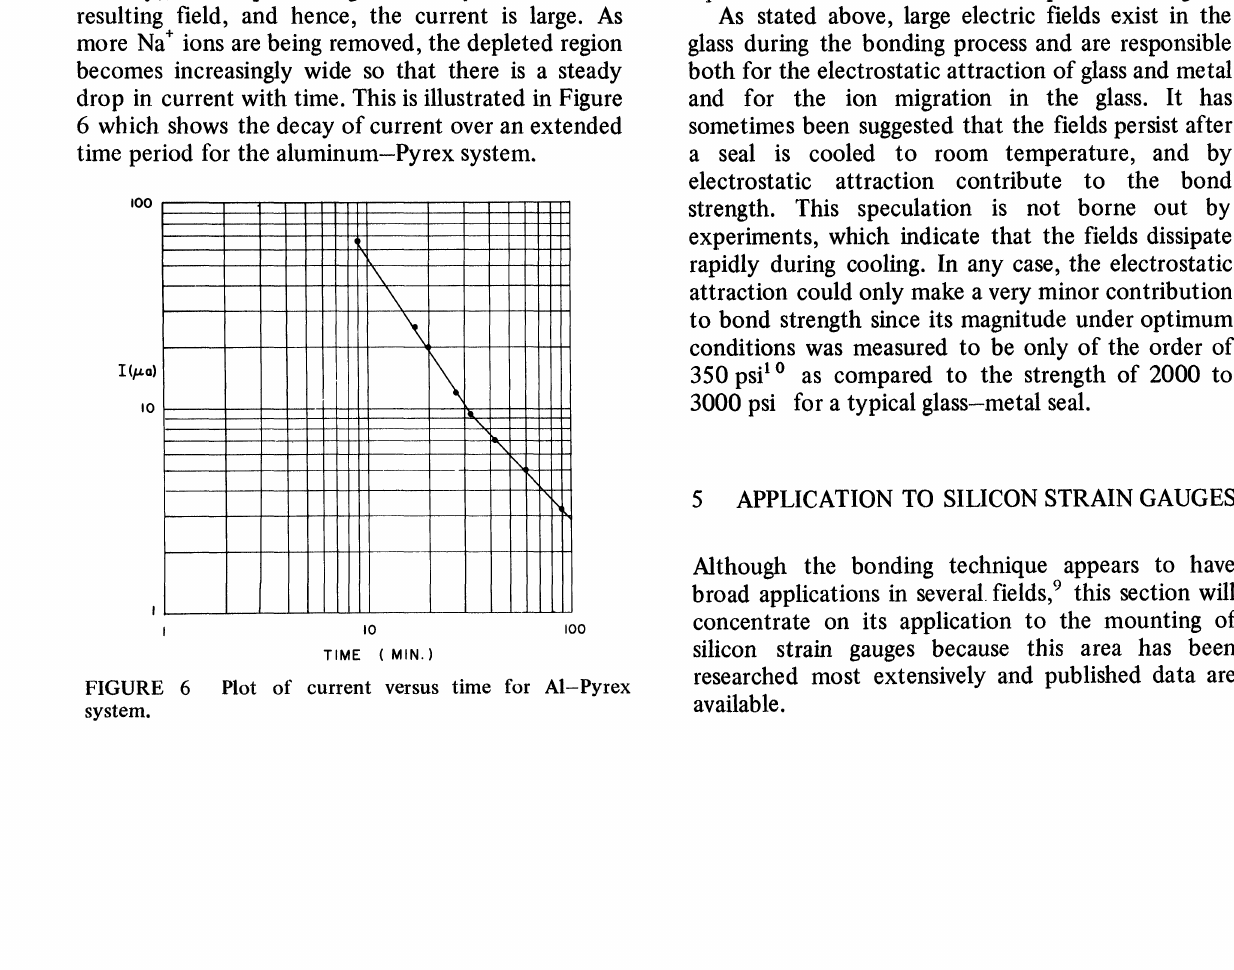
FIGURE 5 Semilog plot of current versus field for AI-Pyrex system. from which the mobile Na* ions have been removed.